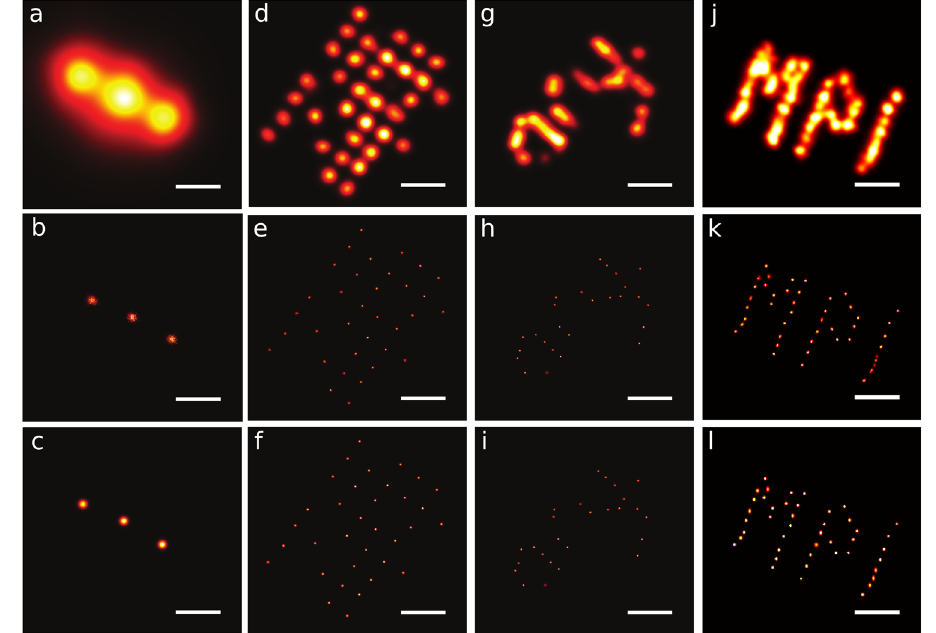
Fig.2|Bayesiangroupingoflocalizationsappliedtovariousstructuresimaged withDNA-PAINT. Row1:TraditionalSRanalysiswitheachlocalizationrepresented by a Gaussian blob of the size of its localization precision. Row 2: Posterior prob- ability image of the chain from BaGoL including all the proposed models. Row 3: The image from the model with the most likely number of emitters (MAPN). a – c Gattaquant DNA rulers with 20nm spacing between docking strands. The shown images were selected from the BaGoL results of 50 similar structures;